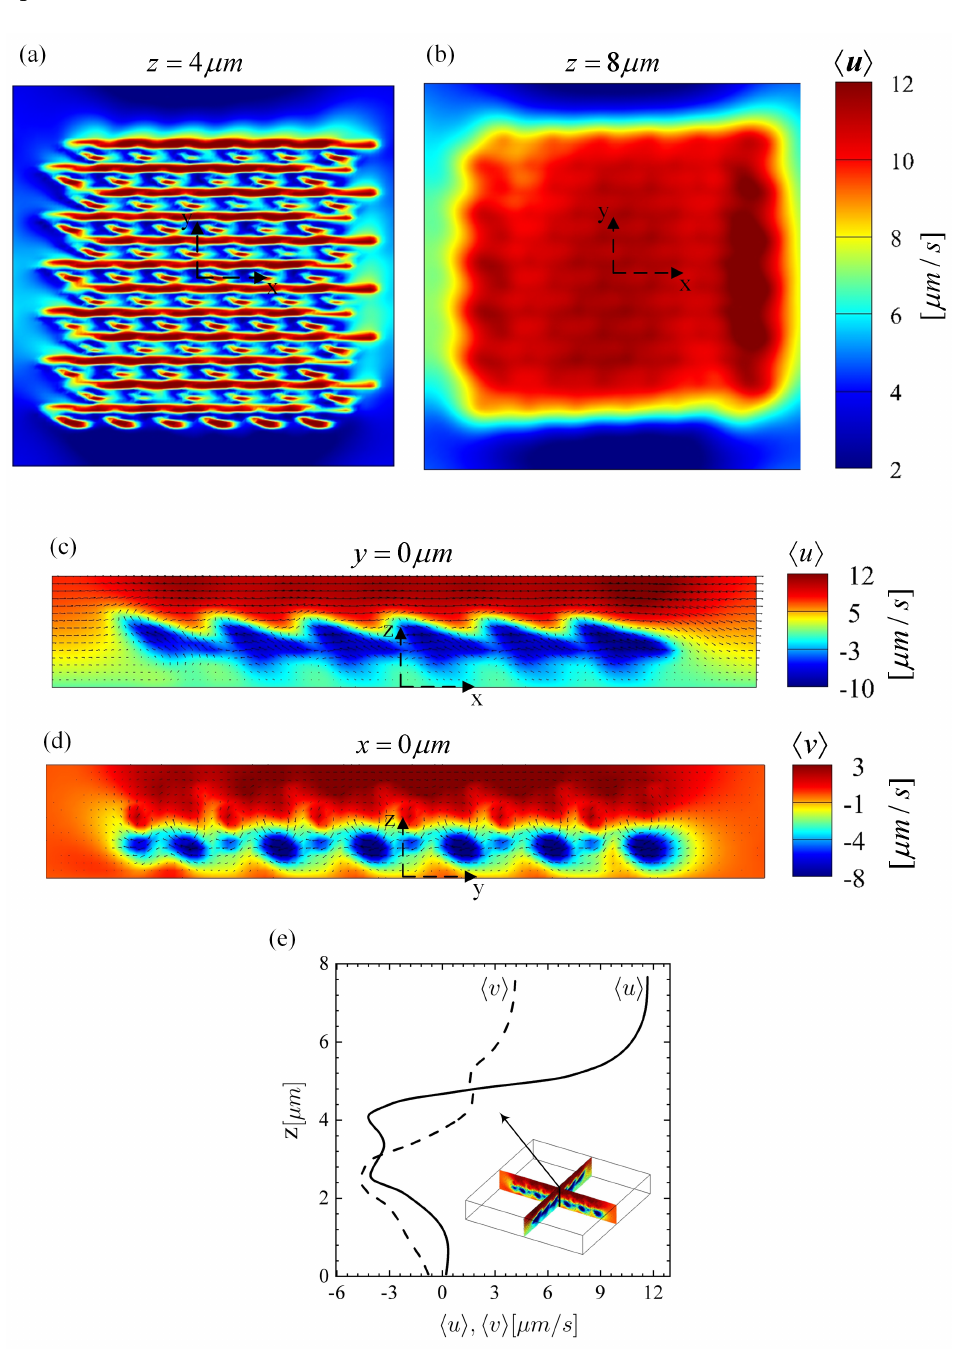
Figure 5. Time-averaged flow velocity. ( a , b ) Contour plots of mean velocity fields at planes z = 4 µ m and z = 8 µ m, respectively. ( c , d ) Velocity contours at planes in the directions parallel ( y = 0 µ m) and perpendicular ( x = 0 µ m) to effective stroke, respectively. ( e ) Flow profiles in the x - and y -directions as functions of z . The profiles are plotted at the intersection of planes shown in ( c , d ) of this figure.